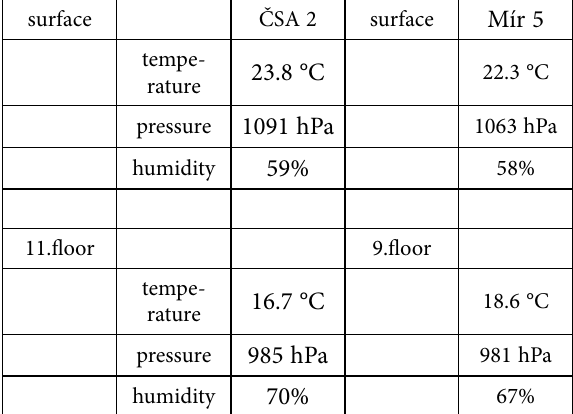
Table 4. Measured values of temperature, pressure and humidity in ČSA 2 shaft and Mír 5 shaft